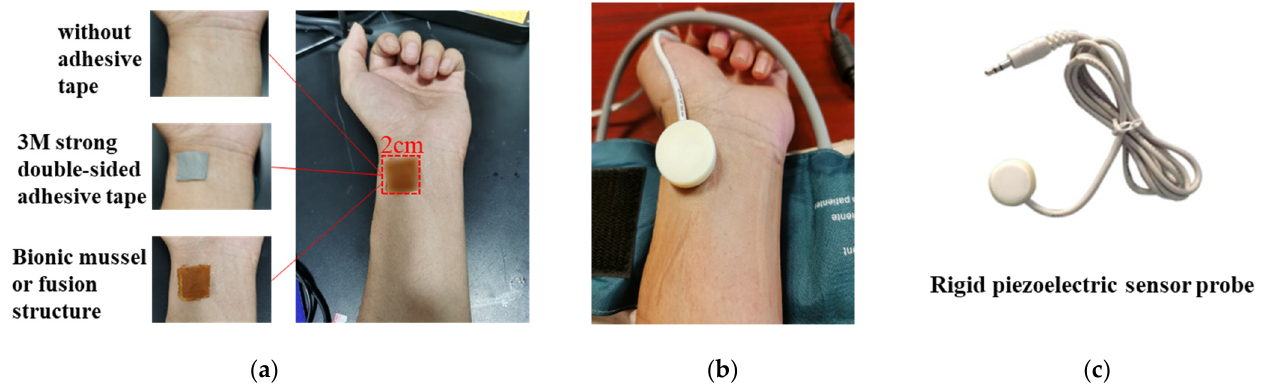
Figure 5. Pulsewave signal acquisition experiment setup: ( a ) Three different conditions of attachment; ( b ) The inflatable wrist band to apply pressure; ( c ) The rigid piezoelectric sensor for the test.